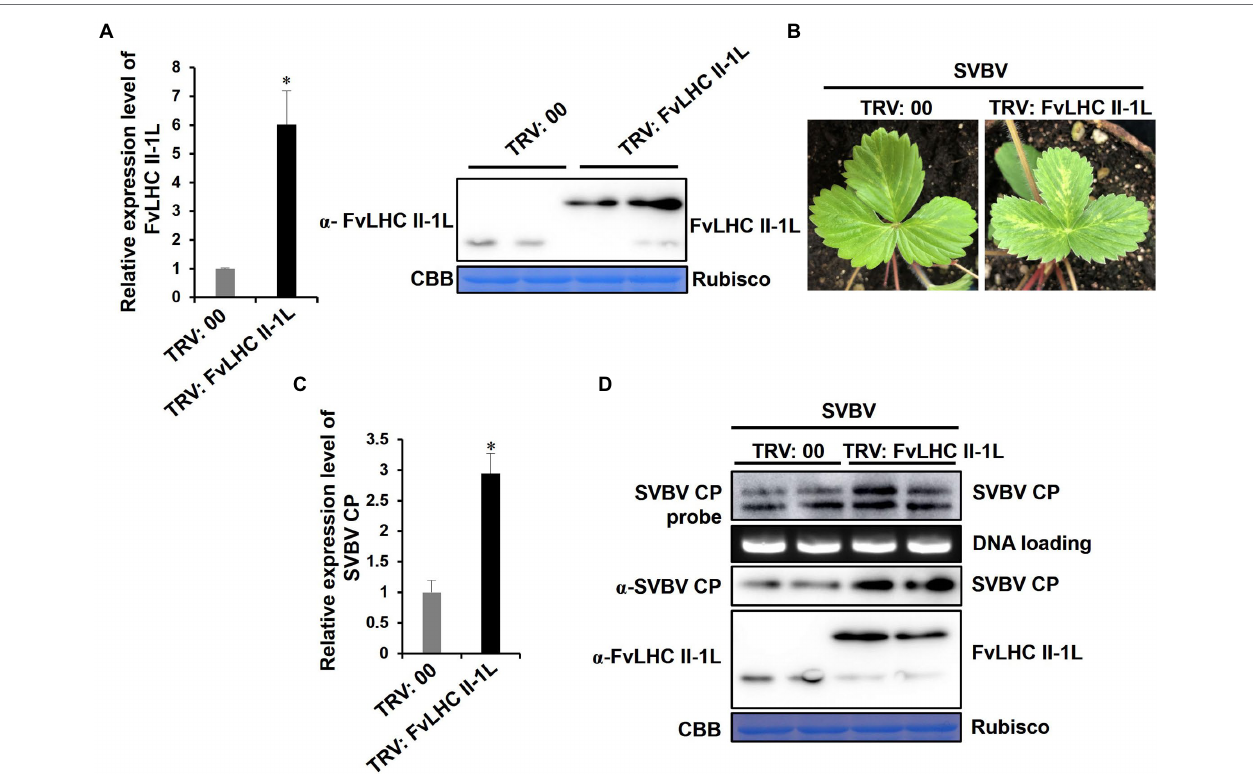
FIGURE 6 | Overexpression of FvLHC II-1L promotes F . vesca infection by SVBV. (A) The transcript levels of FvLHC II-1L and the accumulation of FvLHC II-1L protein in TRV:00-infected or TRV:FvLHC II-1L-infected leaves of F. vesca were determined via RT-qPCR analysis and Western blot at 15 dpi. TRV:00 indicates plants infiltrated with tobacco rattle virus (TRV) empty vector, serving as the negative control. (B) Systemic symptoms of TRV:00 or TRV:FvLHC II-1L pre-infected plants inoculated with SVBV via vacuum-infiltration. The phenotype of SVBV infection was monitored and photographed at 35 days post SVBV inoculation. (C) The transcript levels of SVBV CP in systemically infected leaves of TRV:00 and TRV:FvLHC II-1L pre-infected F . vesca were quantified using RT-qPCR analysis. (D) Accumulation of SVBV CP and FvLHC II-1L proteins and SVBV CP DNA, in systemically infected leaves, was detected via Western and Southern blotting,